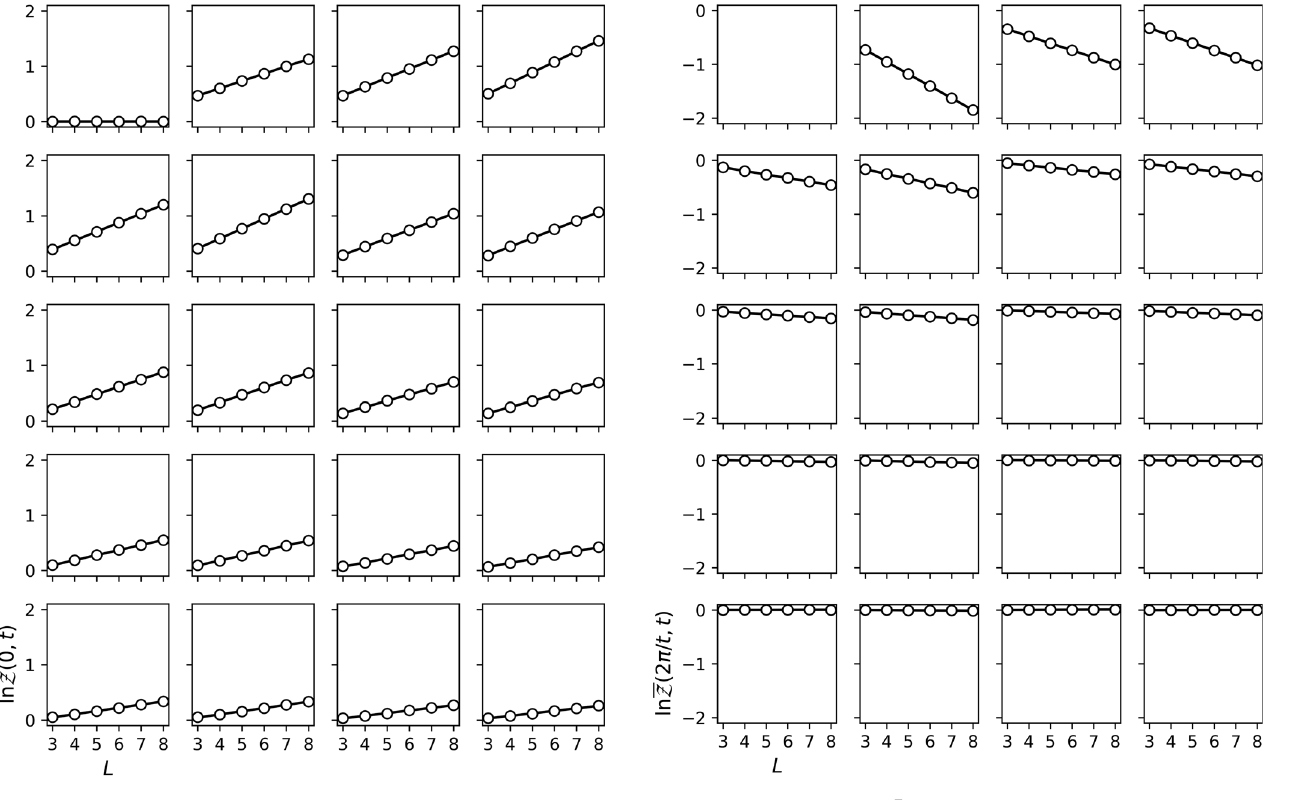
¯ Z ð ω ; t Þ FIG. 31. Scaling of ln with L in sector ω ¼ 0 . The panels correspond to times t ¼ 1 … 20 in reading order. From linear fits, we extract the leading eigenvalue λ ð ω ; t Þ and the overlaps of the corresponding eigenvectors with the local diagonal states, h ω j ω ; t ; R ih ω ; t ; L j ω i , in this sector.